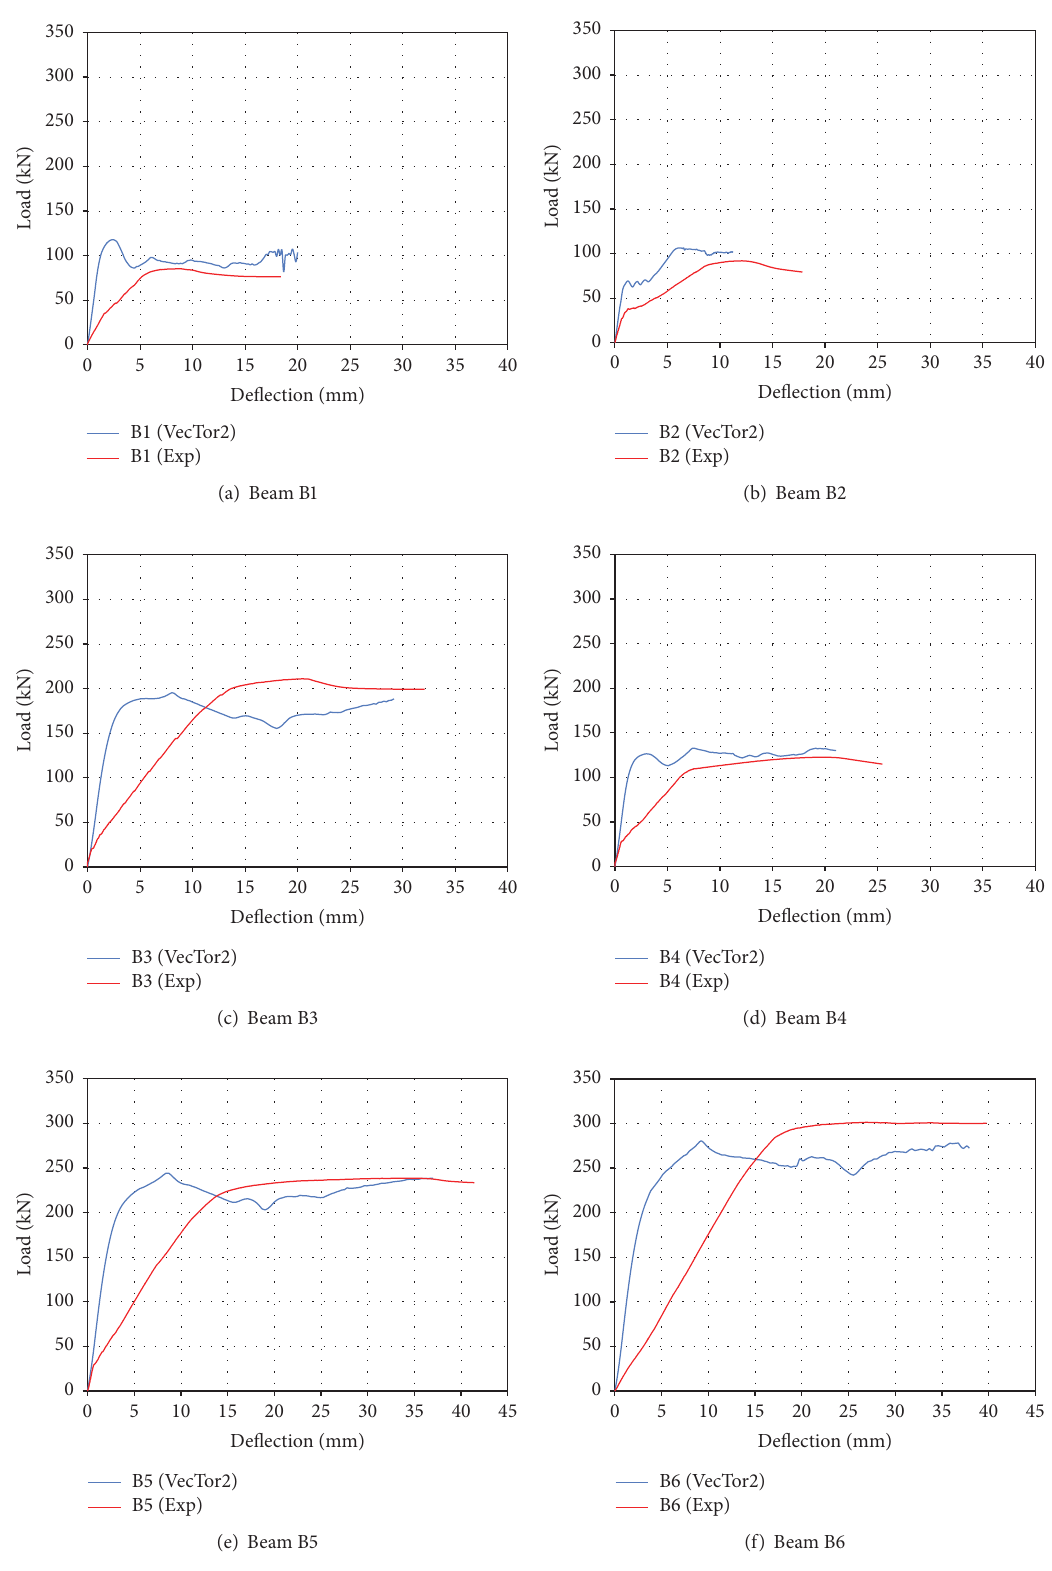
Figure 20: Load-deflection relationships for R-SC-ECC